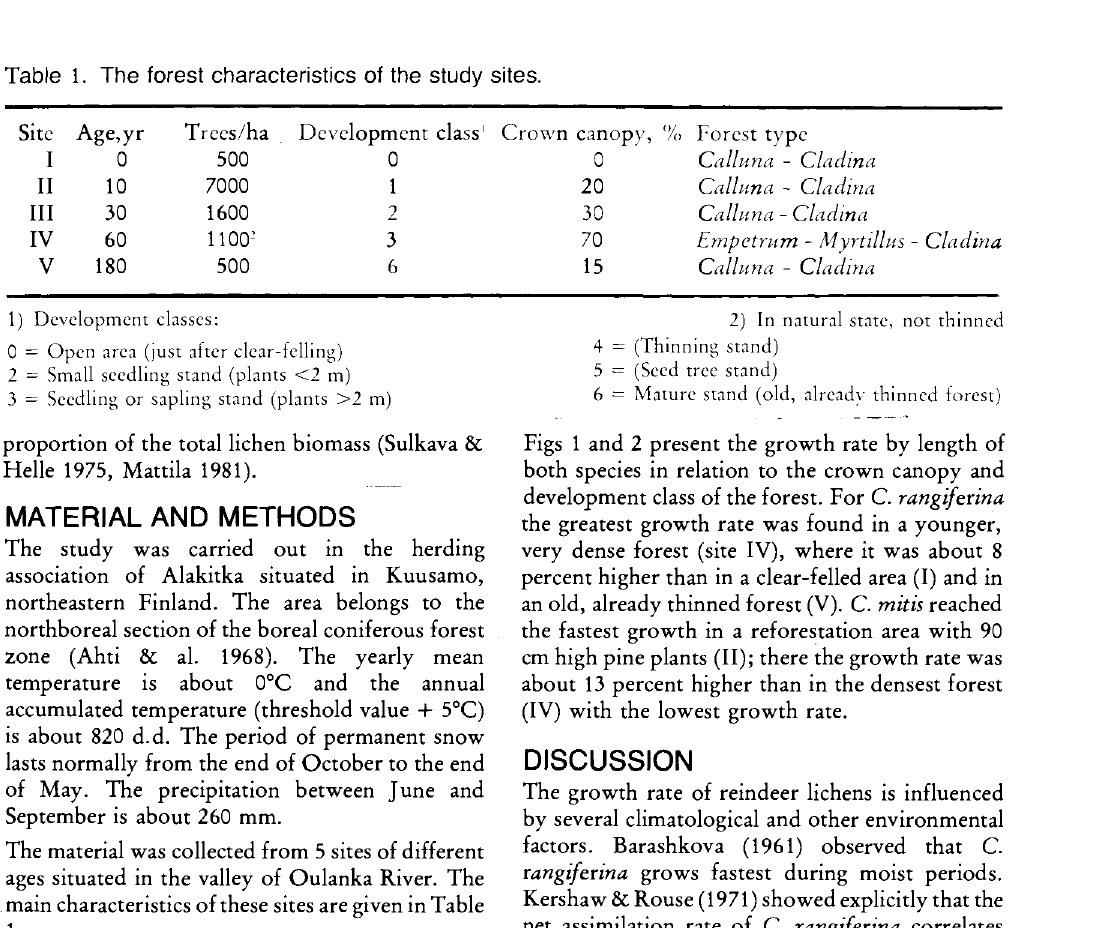
Table 1. The forest characteristics of the study